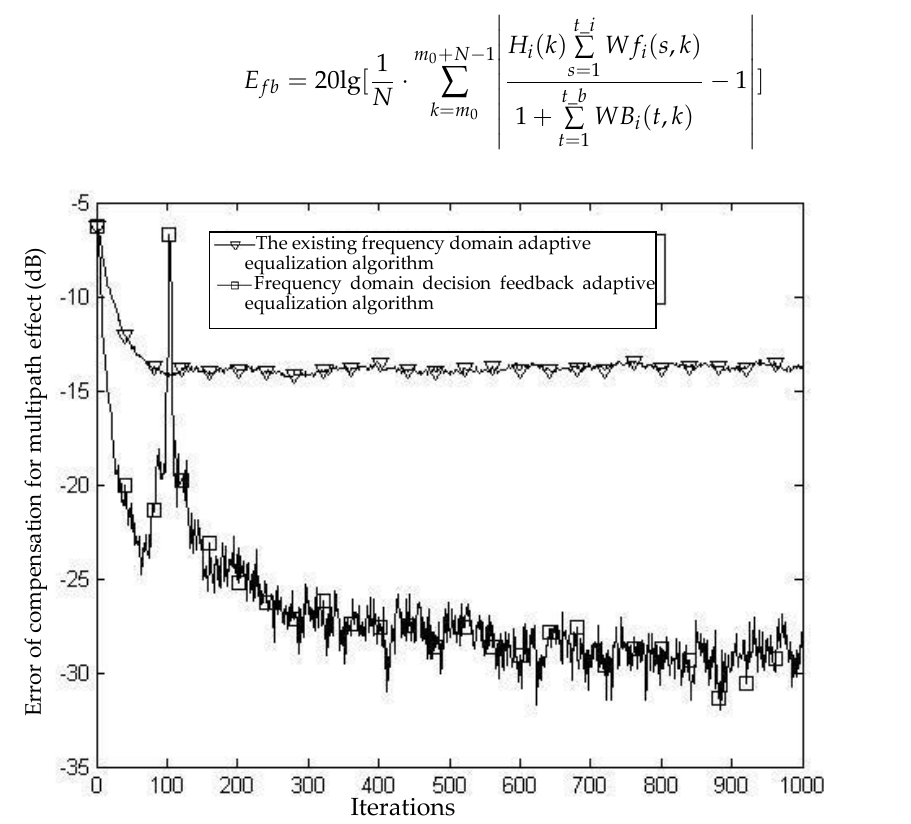
Figure 5. Error curve of compensation for Channel 2 with two frequency domain equalization algo- rithms.